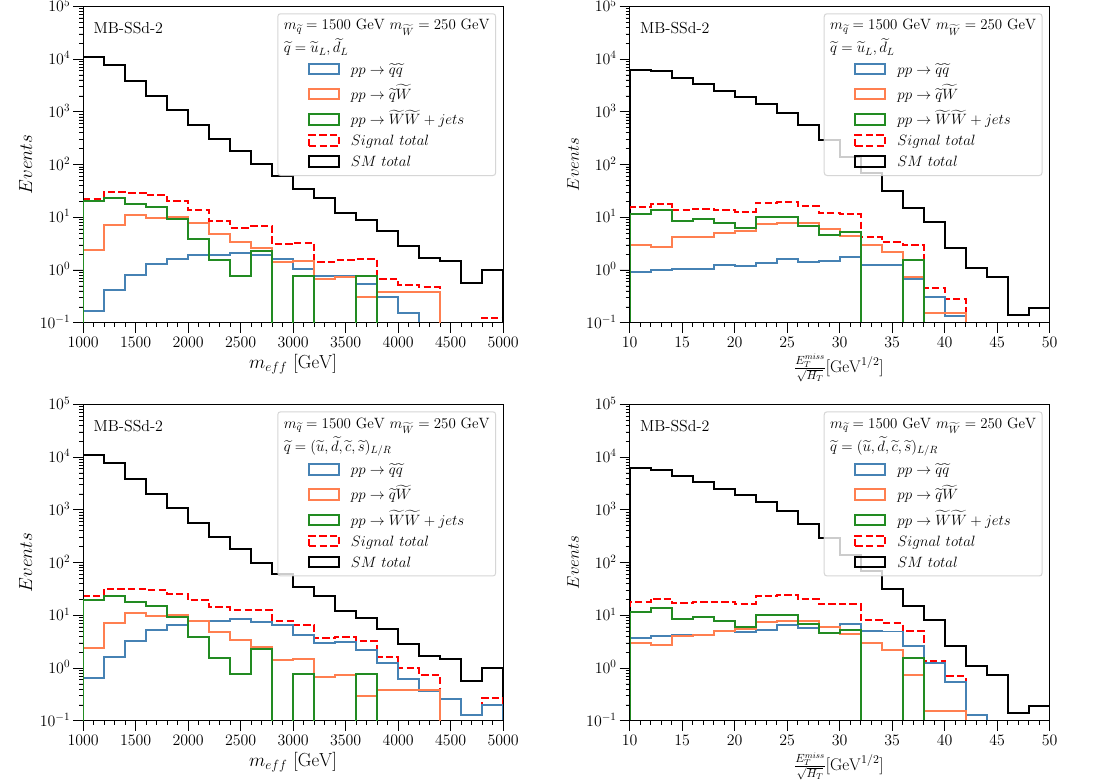
Figure 5 . The m eff (left) and E miss / √ H T (right) distributions in the MB-SSd-2 signal region in T the 2-flavour (top) and 8-flavour (bottom)